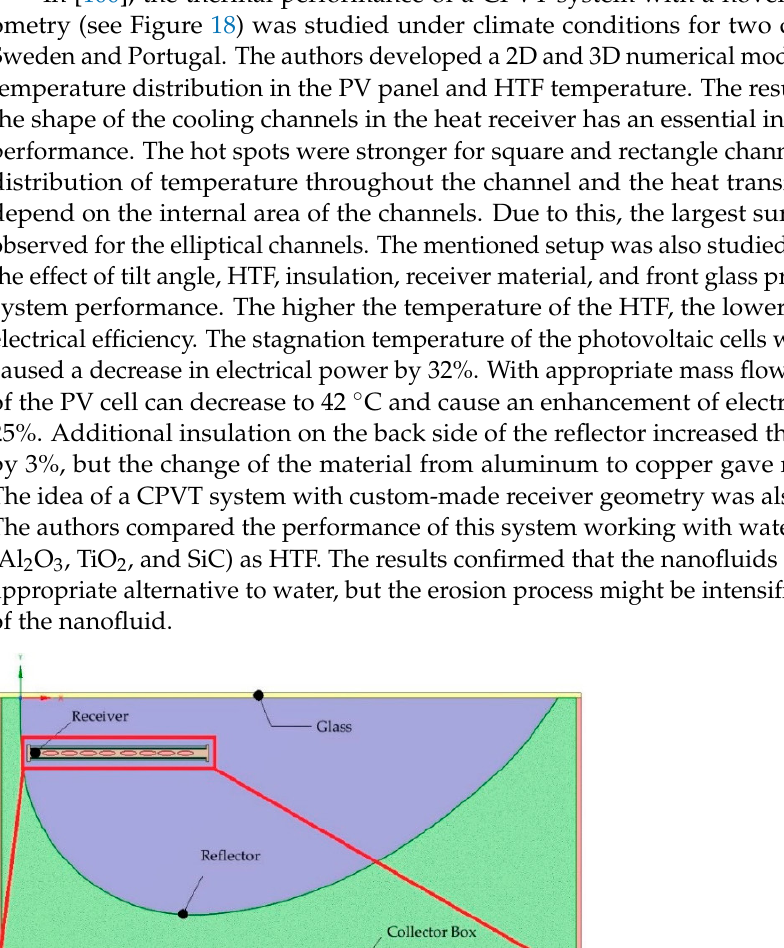
Figure 17. The cross-sectional view of heat receiver tested in [99]. Reprinted with permission from Ref. [99]. 2019, Elsevier.